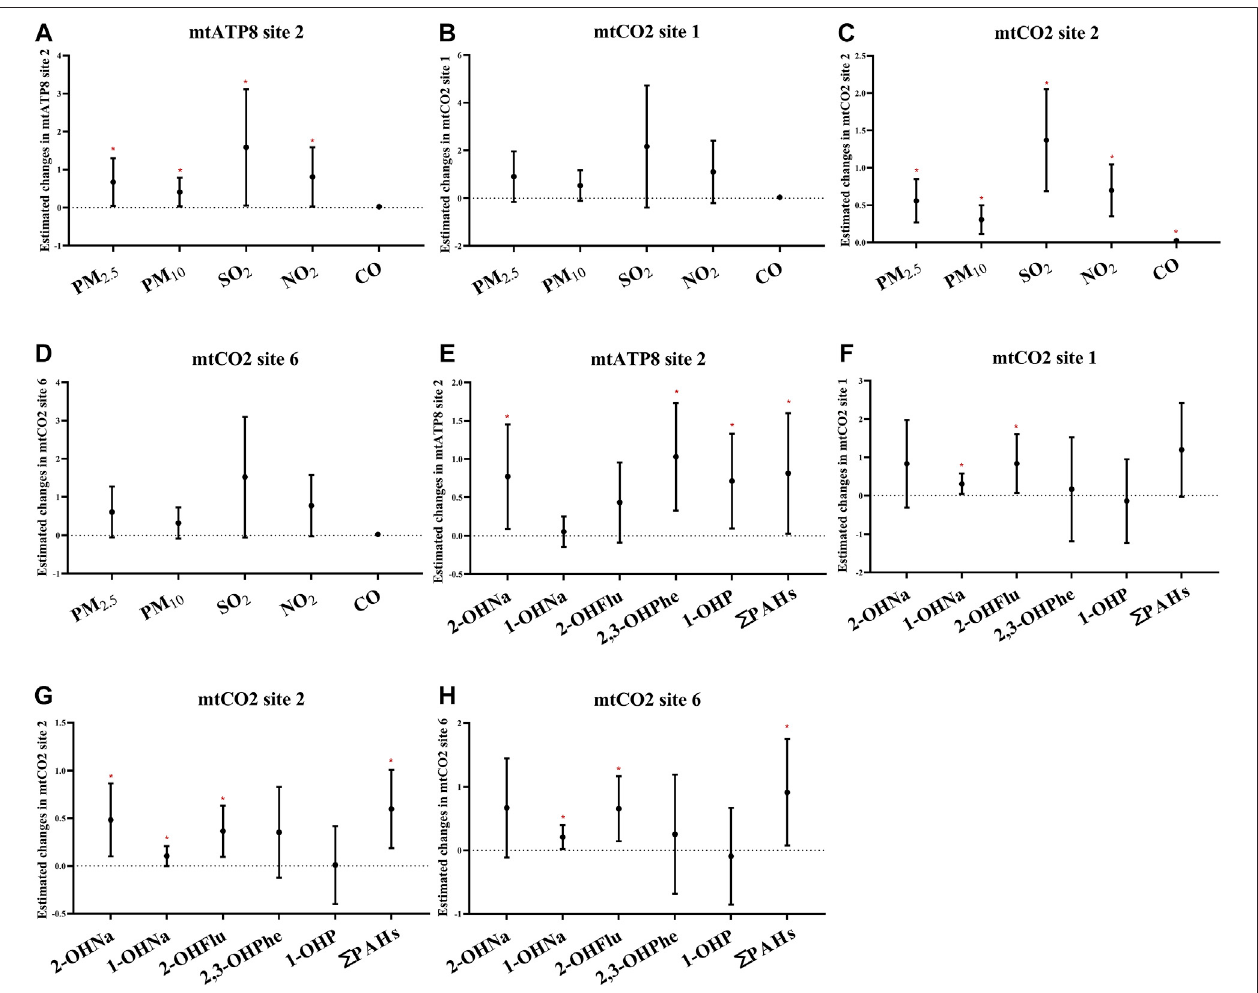
FIGURE 5 | Estimated changes (95% con fi dence intervals) of platelet mitochondrial DNA methylation in the thrombocyte parameters. Changes (95% con fi dence intervals) in the biomarkers with IQR increases in air pollution indicators and PAHs were calculated. (A – D) Indicates the situation of each pollutant, separately. (E – H) Indicate the situation of PAHs. Models adjusted for age, BMI, height, and smoking status. * denotes p < 0.05.